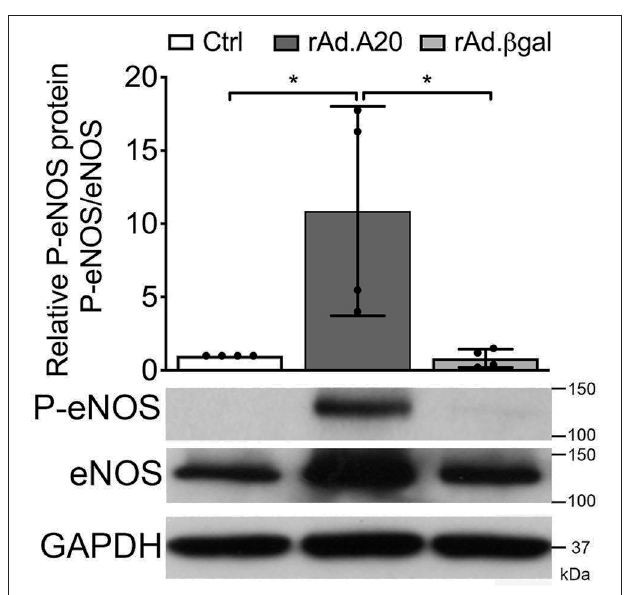
FIGURE 6 | A20 overexpression increases basal Ser-1177 eNOS phosphorylation in HCAEC. Representative WB of total eNOS and P-eNOS (Ser-1177) in non-transduced HCAEC (Ctrl) and HCAEC transduced with rAd.A20 or rAd. β gal at 100 MOI for 48h; GAPDH was used to correct for loading. Densitometry results are presented as mean fold change of Ctrl ± SEM ( n = 4). * p < 0.05, as determined by one-way ANOVA followed by the Tukey post hoc